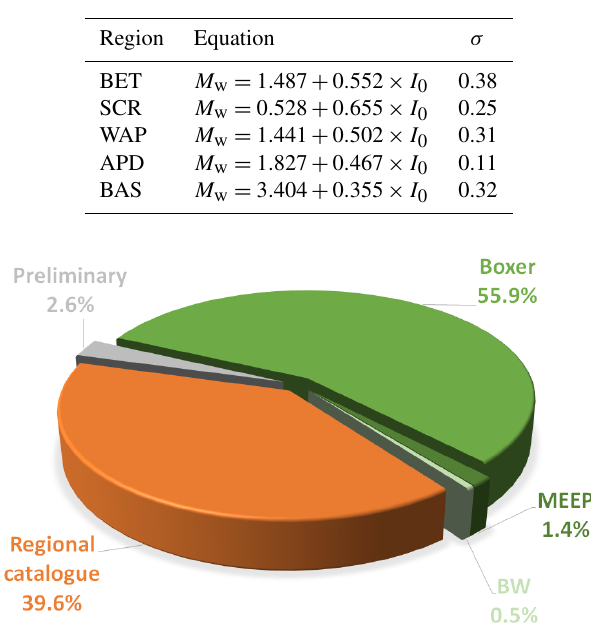
Figure 5. Percentages of the different types of epicentre locations in EPICA. “Boxer”, “MEEP” and “BW” indicate the methods used for assessing epicentre from macroseismic data. Preliminary means that a robust determination of the location is not possible with the available